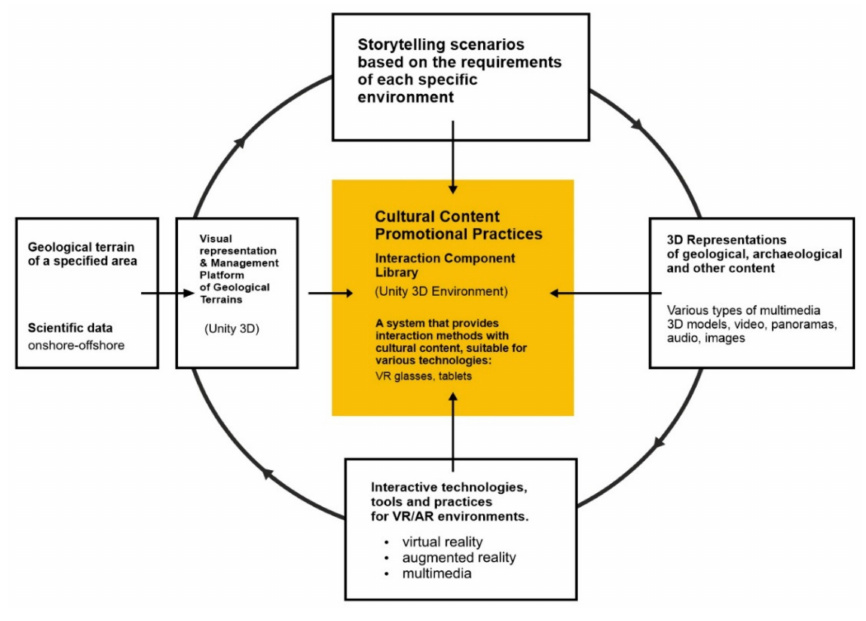
Figure 8. Overall system architecture.